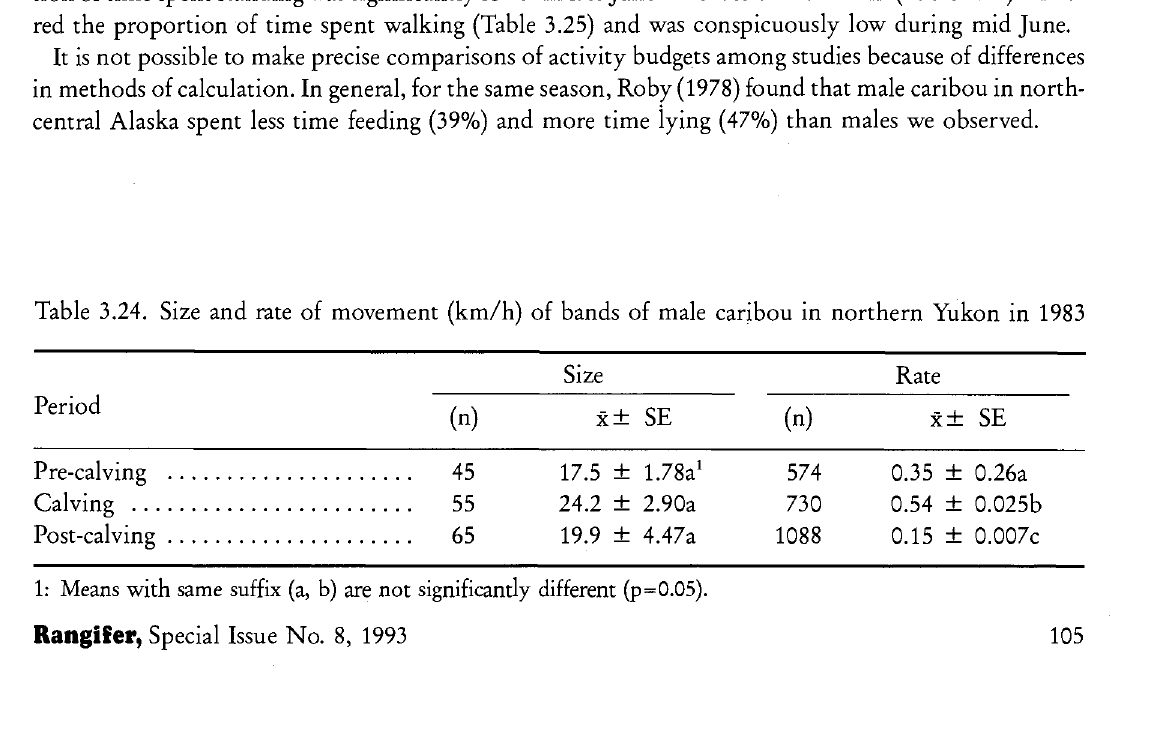
Table 3.24. Size and rate of movement (km/h) of bands of male caribou in